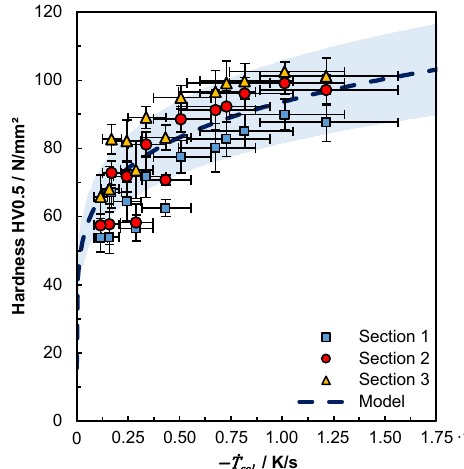
Figure 5. Hardness in HV0.5 as a function of the calculated cooling rate. The blue dashed line corresponds to Equation (4). The uncertainty due to the variable material properties is represented by the blue shaded area. The points show the experimentally measured hardness averaged over 30 measurements, where the cooling rate was calculated using Equation (9). The height of the error bars shows the standard deviation of the measurements; the length of the error bars in horizontal direction shows the uncertainty due to the variable material properties. The orange dashed line in Figure 6 corresponds to the proposed model given by Equation (10) with λ th = 150 W , T sol = 585 ◦ C, C fit = 170 N , and k = 2.615. The light orange shaded area indicates the same material-related uncertainty as mentioned above. The red dots show the hardness as an average across all measurements in the three sections, and over the three samples produced with the same process parameters. The error bars of the hardness are again given by the standard deviation. The horizontal error bars take into account the possible variation of the absorptance η Abs ± 5 %. The results show an excellent agreement between the proposed model and the experimental